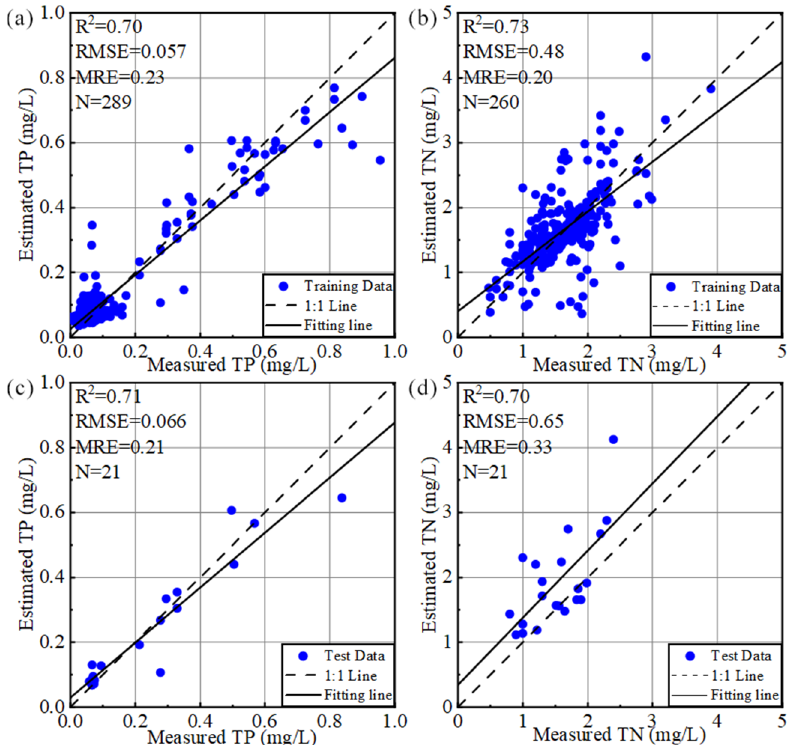
Figure 3. Performances of TP inversion model, including training datasets ( a ) and test datasets ( c ) based on GP model, and performance of TN inversion model, including training datasets ( b ) and test datasets ( d ) based on NN model.